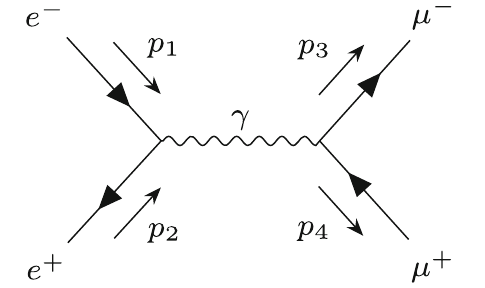
Fig. 1 S -channel e − e + → μ − μ + diagram with photon mediator. We use p 1 , p 2 , p 3 and p 4 to label the external momenta